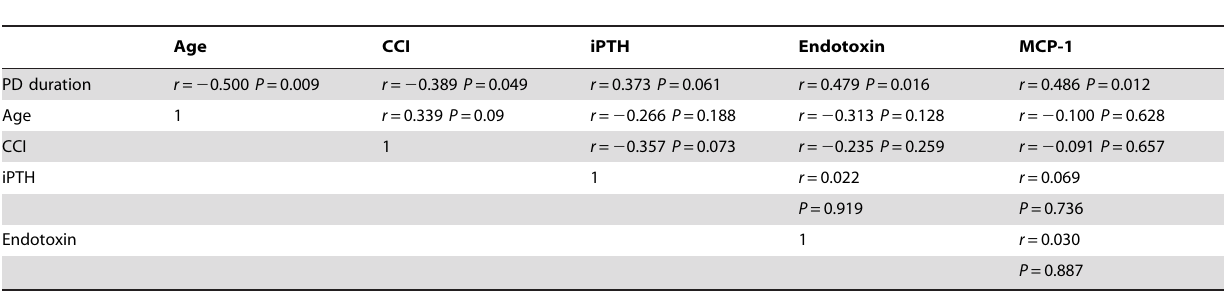
Table 3. Correlations between PD duration, clinical parameters, and cytokine